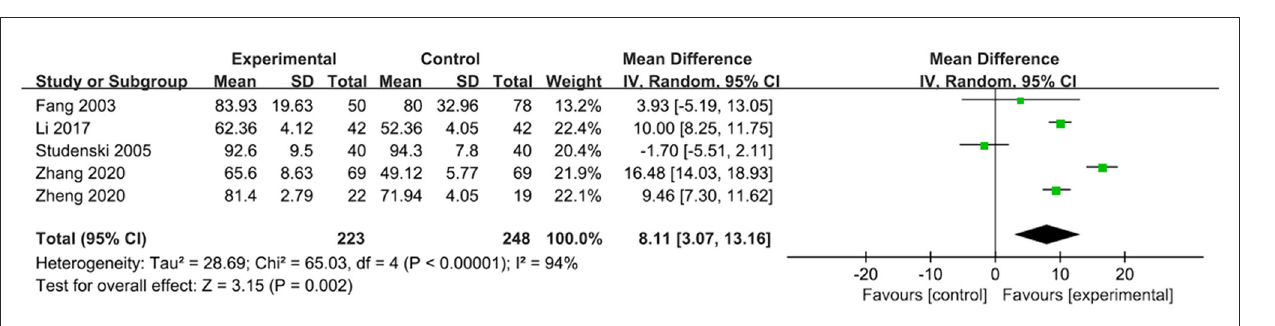
FIGURE6 Effects of exercise therapy on activities of daily living in patients with